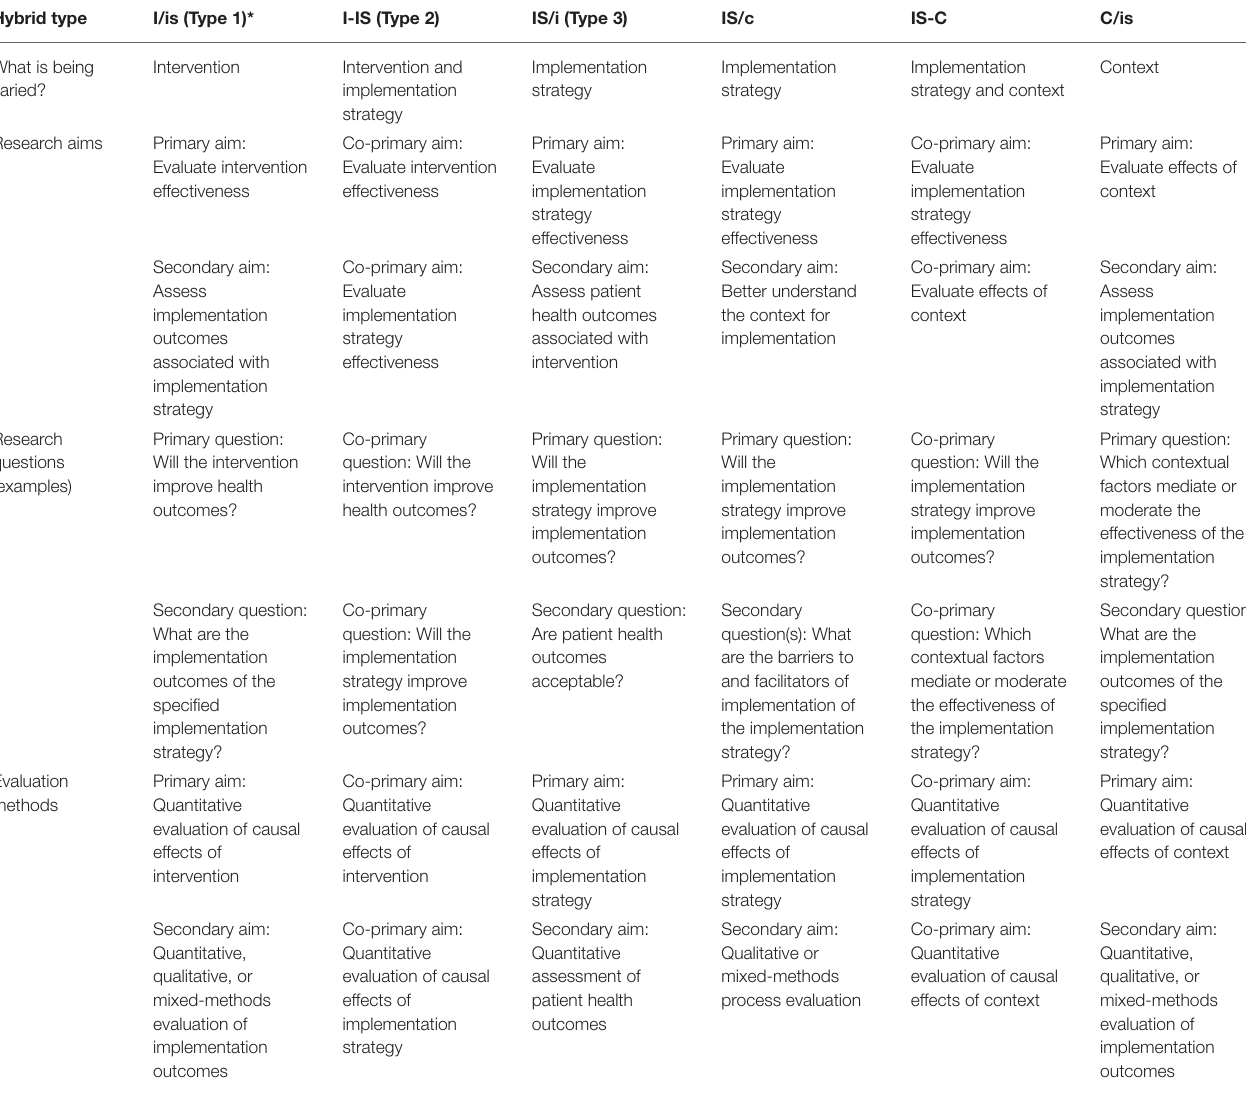
TABLE 1 | Two-variable hybrid types that include assessment of implementation strategy. Hybrid